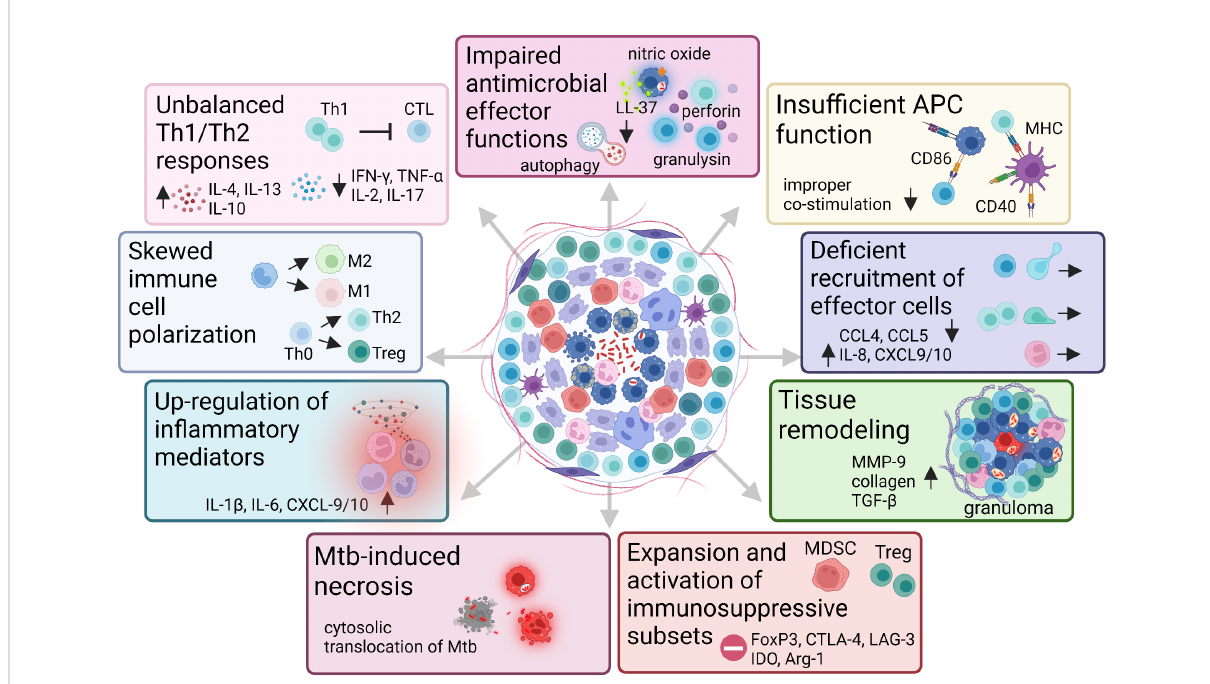
FIGURE 2 TB control depends on cellular immunity induced in the local GME. Schematic summary of the immune cell alterations and de fi cient immune pathways that have been described related to induction and maintenance of cellular immunity in the TB granuloma microenvironment. Note that the illustration shows some of the major alterations of cellular immunity in the GME and should not be considered